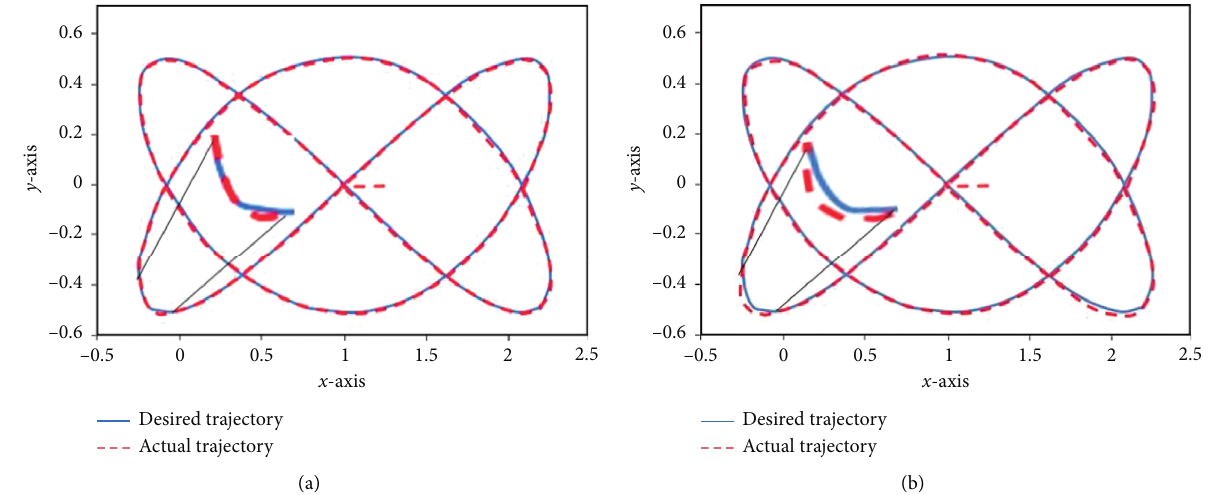
Figure 10: Desired and actual lemniscates trajectory of DDMR: (a) with NNFOPID controller and (b) with NNPID controller.